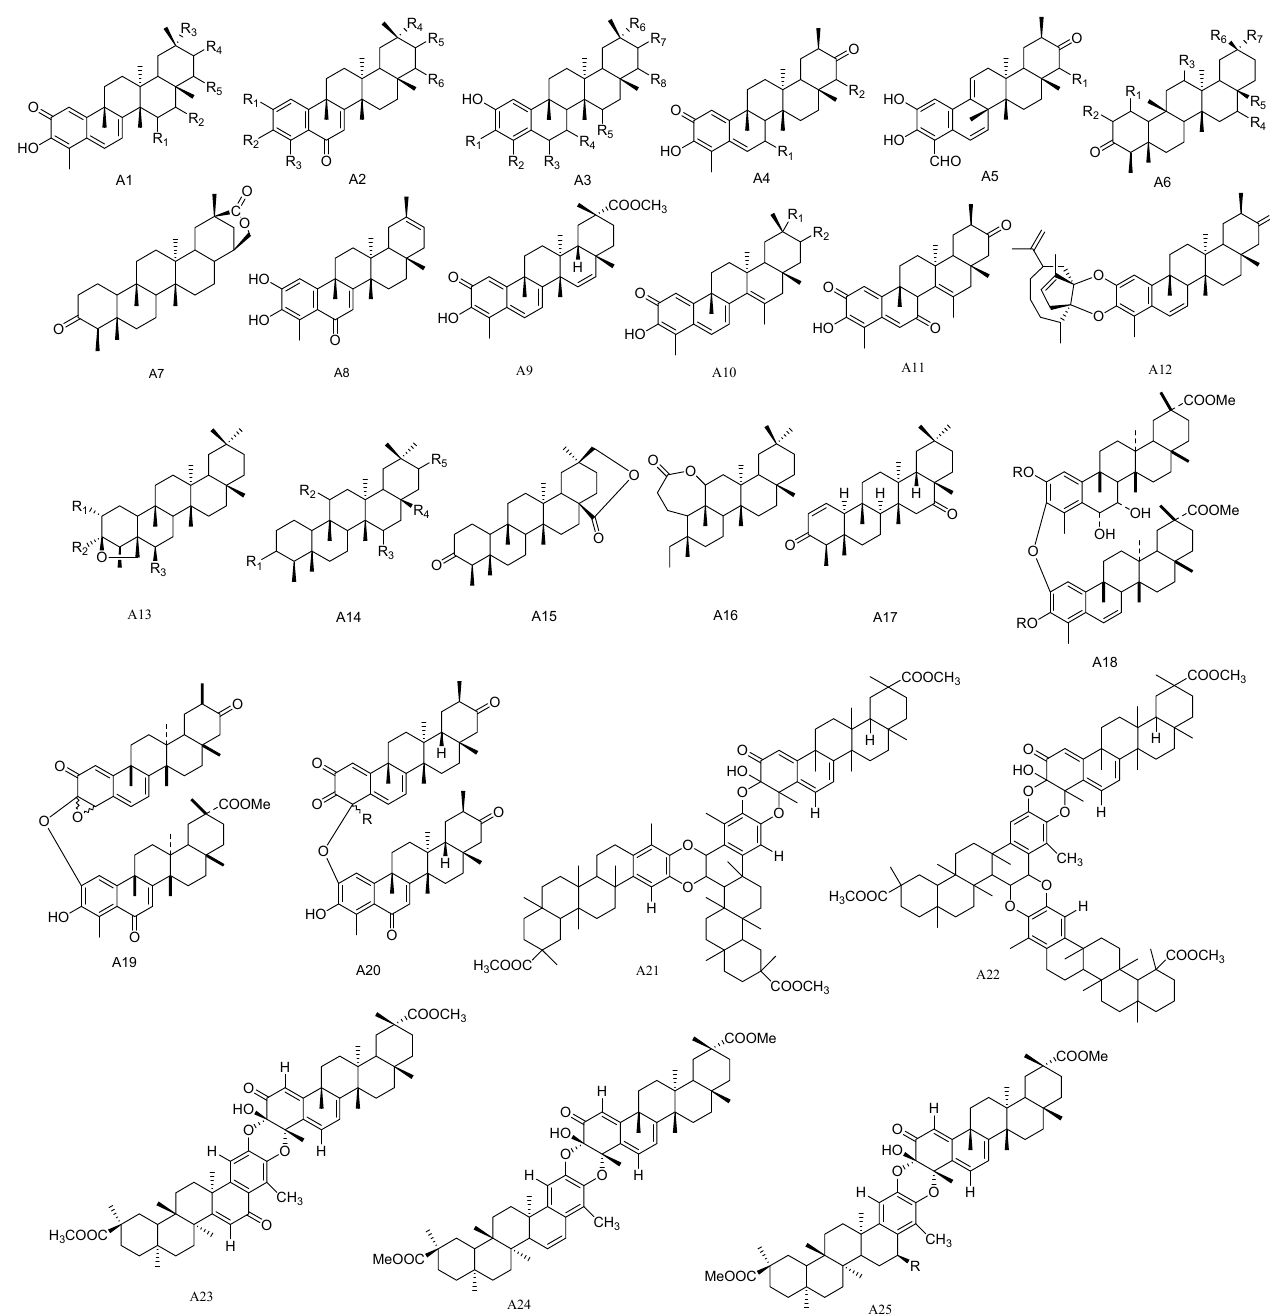
Figure 1. Twenty-five types (A1–A25) of friedelane triterpenoids skeletons.